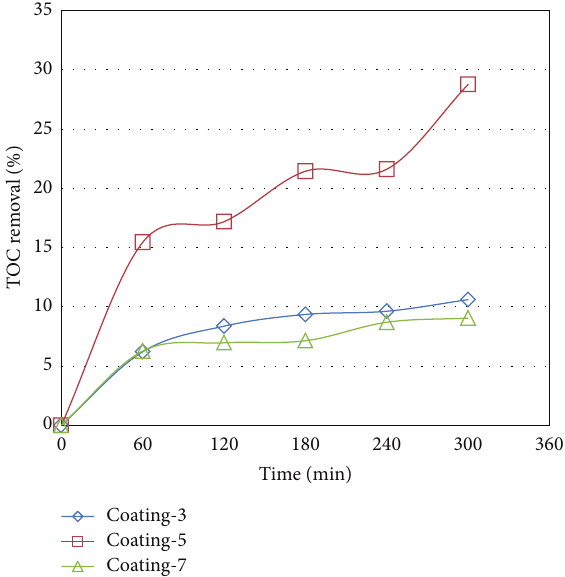
Figure 5: Corresponding TOC removals after photocatalysis with different TiO 2 coating times.